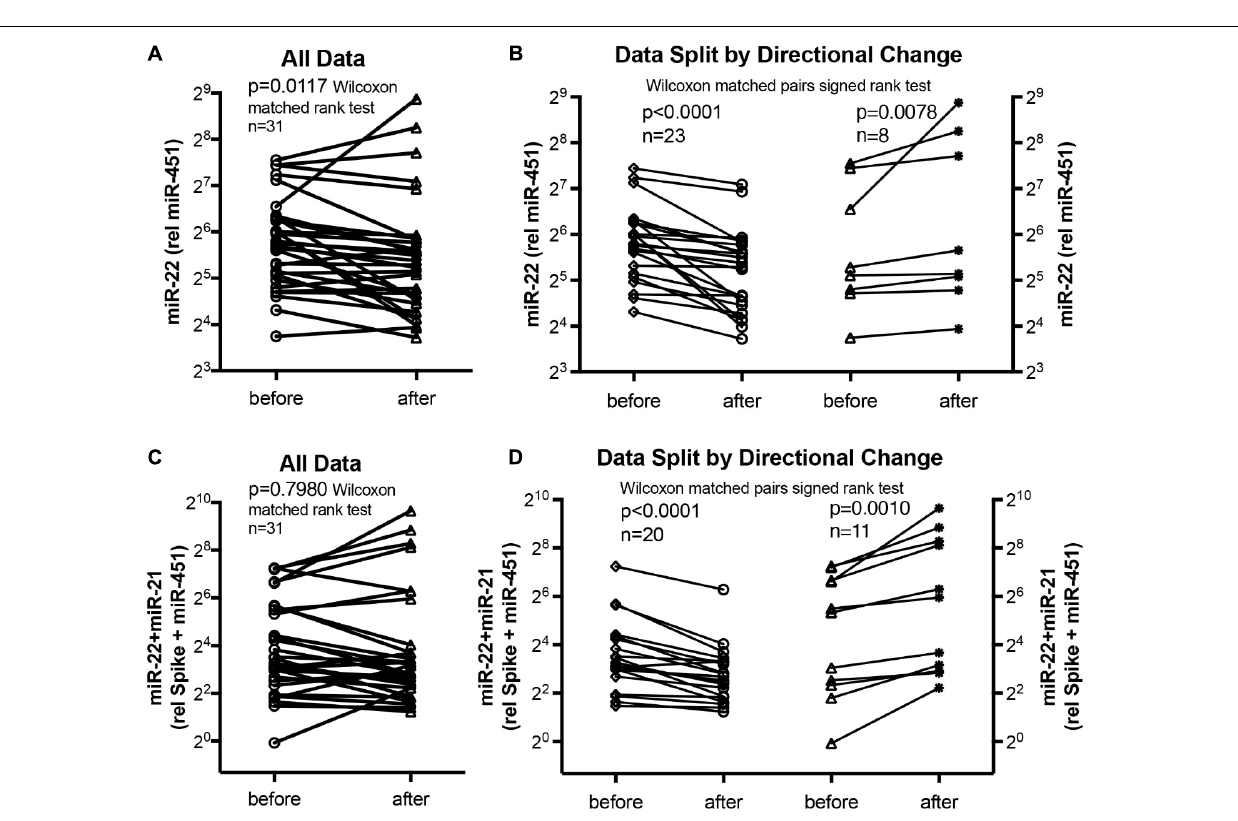
FIGURE 2 | Circulating serum miRNA values in the supervised exercise training intervention study. Symbols and lines graphs show miR-22-3p relative to miR-451a (10,000 × ) values (A,B) , or miR-22-3p + miR-21-5p relative to spike-RNA + miR-451a (10,000 × ) values (C,D) in serum samples obtained from patients (Ehlken et al., 2016; Grunig et al., 2012a) before and after exercise training intervention. All of the data are plotted in (A,C) ; in (B,D) the data are separated by the directional change in the samples after exercise training intervention. Groups before and after intervention were compared with the Wilcoxon matched pairs signed rank test; p < 0.05 was considered